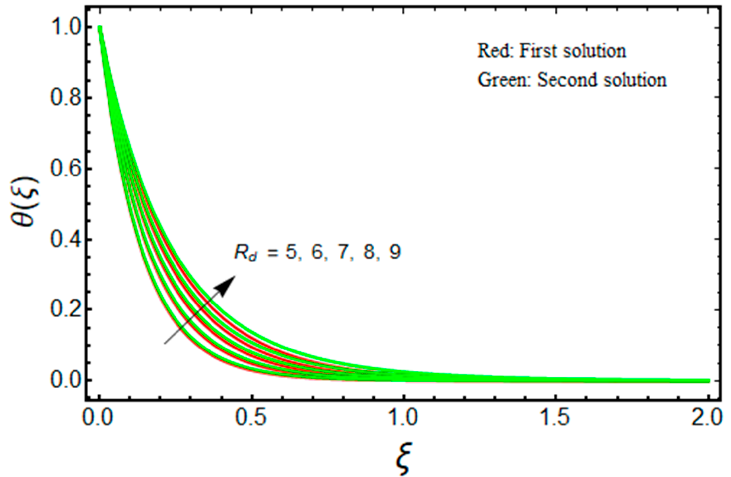
Figure 12. Effect of R d on −